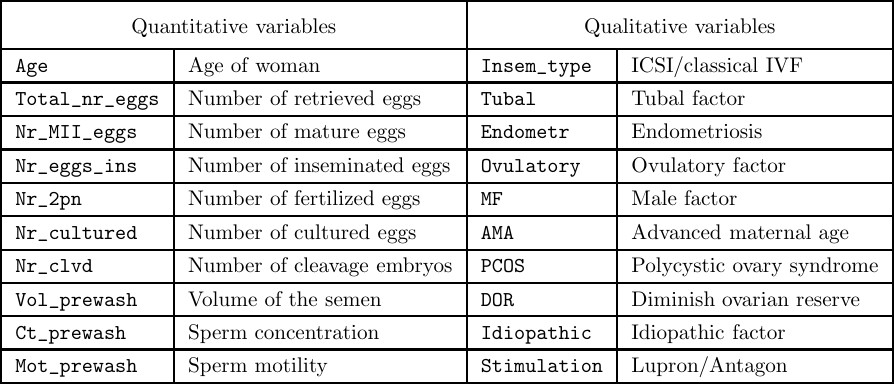
Table 1. List of independent